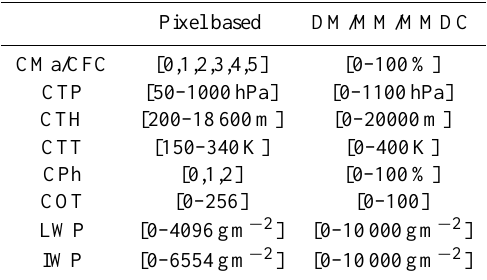
Table 2. Occurring ranges of CLAAS cloud products per cloud vari- able and processing level: pixel-based products, daily mean (DM), monthly mean (MM), monthly mean diurnal cycle (MMDC).